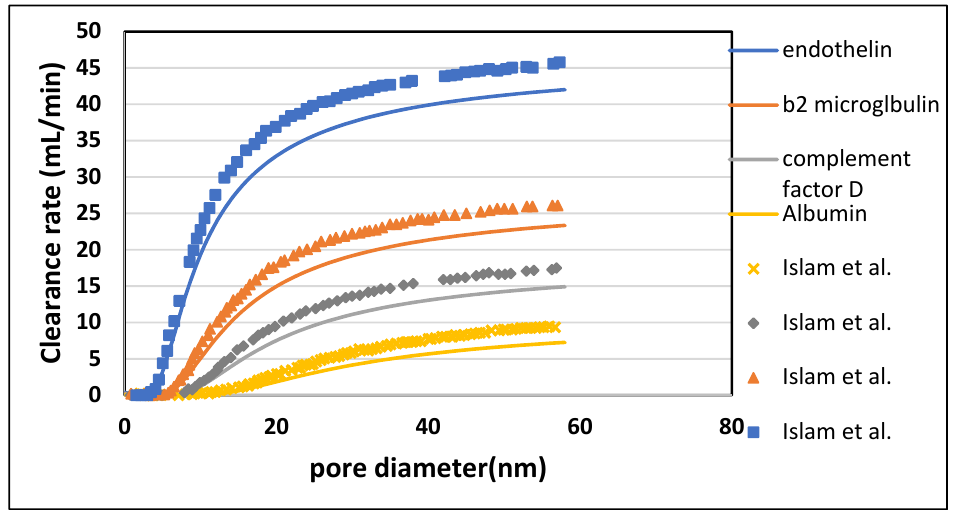
Figure 15. Effect of pore diameter on the clearance rate of large molecular weight (LMW) molecules.